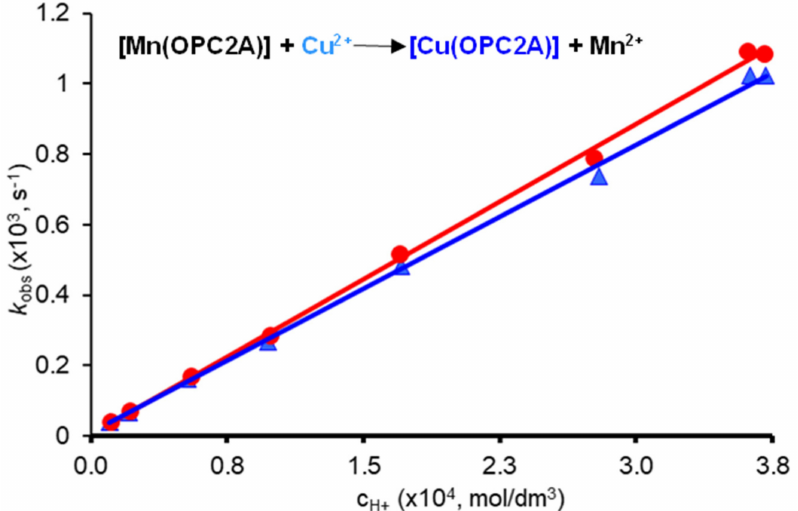
Figure 4. Plot of the pseudo-first-order rate constants ( k obs ) as a function of [H + ] ion concentration for [Mn( 3,9-OPC2A )], observed by using different exchanging metal ion concentrations (20-fold ( • ) and 40-fold ( (cid:78) ) Cu(II)